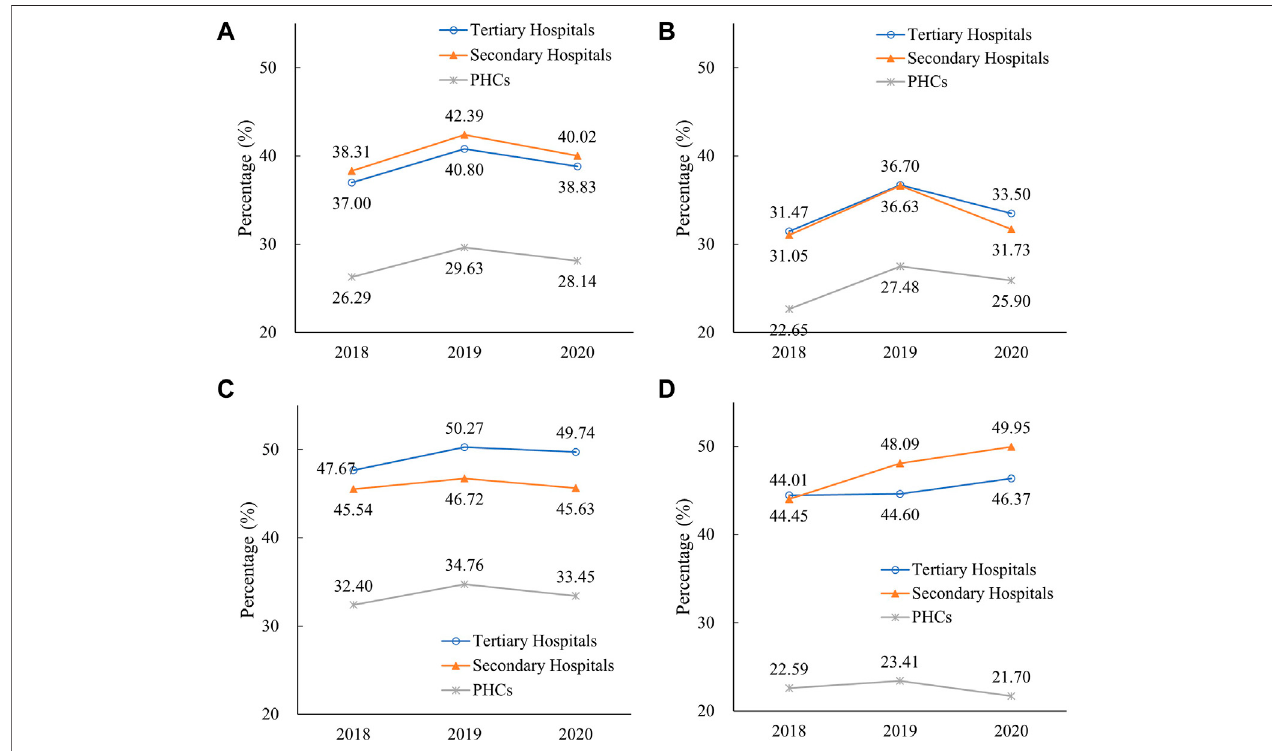
FIGURE 4 | Utilization proportion of parenteral antibiotics in different medical institutions in China, 2018 – 2020. (A) Overall, (B) eastern China, (C) central China, and (D) western China. Note: Data of 24 provinces were involved. PHCs, primary healthcare centers.